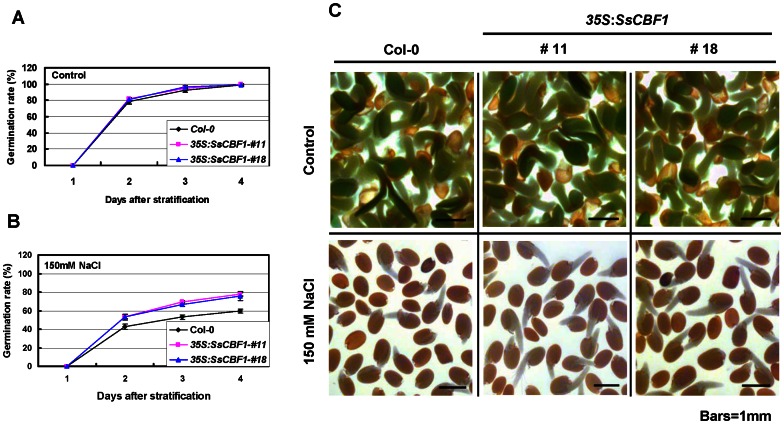
Seed germination of transgenic Arabidopsis in response to NaCl.(A–B) Seed germination ratio of Col-0 and two OE lines in the absence or presence of NaCl. Seeds from different genotypes were germinated on 1/2 MS agar plates (control, A) or supplemented with 150 mM NaCl (B), respectively. Germination was defined as the obvious sign of radicle tip emergence and scored daily until the indicated day. Data shown are average and SD of four independent experiments (each with 100 seeds for each genotype). (C) Increased tolerance of SsCBF1 transgenic lines to salt stress. Pictures were taken 3 days after stratification.